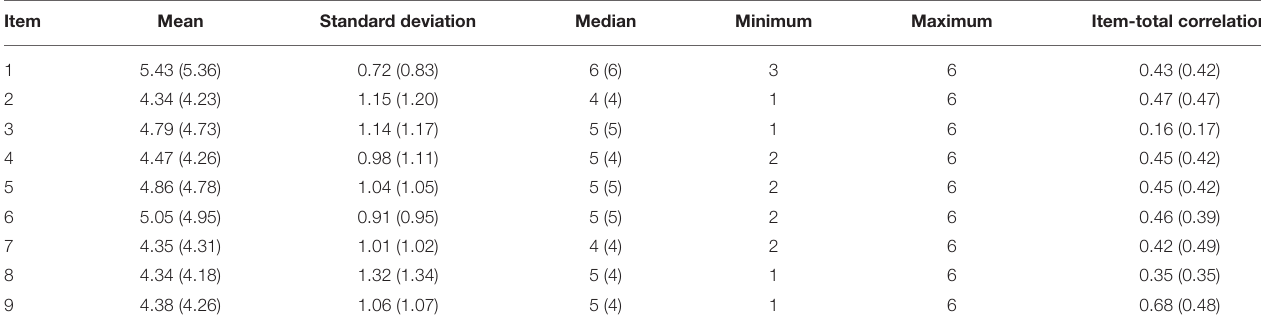
TABLE 1 | Beginning and End a of fall semester item descriptive statistics.